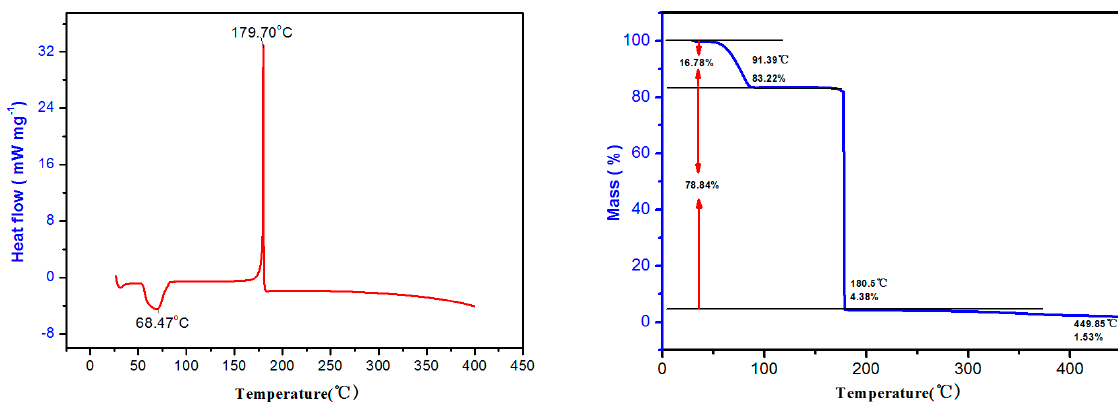
Figure 4. DSC-TG experiments of NPTO ∙ 2H 2 O.